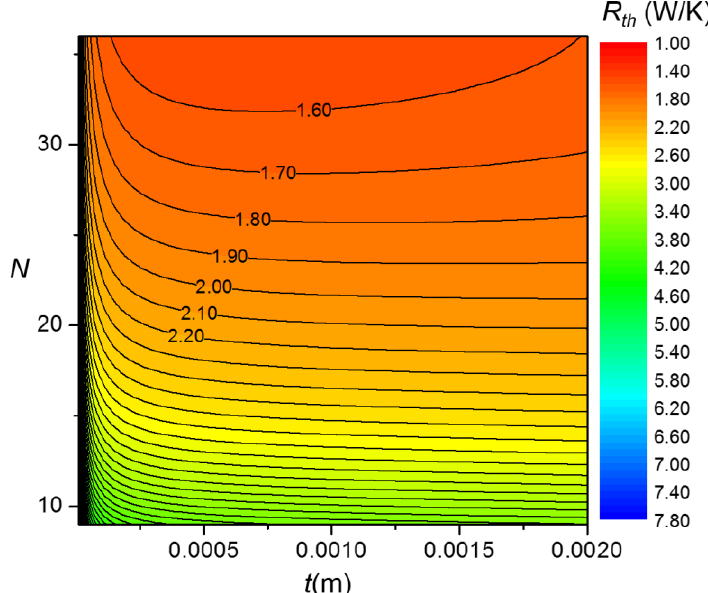
Figure 11. Contour map of thermal resistance of the cylinder with conventional radial plate fins for various fin numbers and fin thicknesses for ( H = 30 mm, D = 60 mm, L = 50 mm, T w − T amb = 50 °C, k f = 0.026 W/m K, k s = 220 W/m K, ν f = 1.6 × 10 −5 m 2 /s, α f = 2.23 × 10 −5 m 2 /s, β f = 0.0033/K).